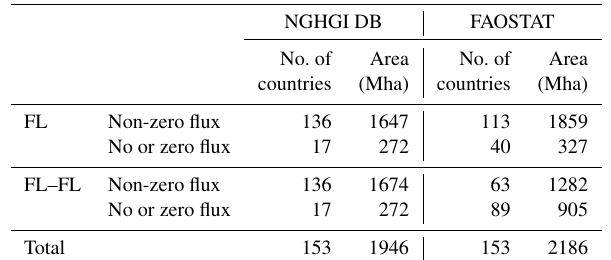
Table 8. Statistics on the number of NAI countries (and correspond- ing forest area) for which NGHGI DB and FAOSTAT compute null or non-null carbon fluxes for forest land (FL) and “forest land re- maining forest land” (FL–FL). To note is that FAOSTAT does not explicitly distinguish the two subcomponents of FL, i.e. FL–FL and land converted to forest (L–FL). Here, we performed an additional analysis based on the original country reports to FRA: if the coun- try report to FRA includes a constant value of carbon stock/ha over time, then we assume that the carbon flux FL–FL is zero and that any value computed by FAOSTAT for FL comes from L–FL only (see text for